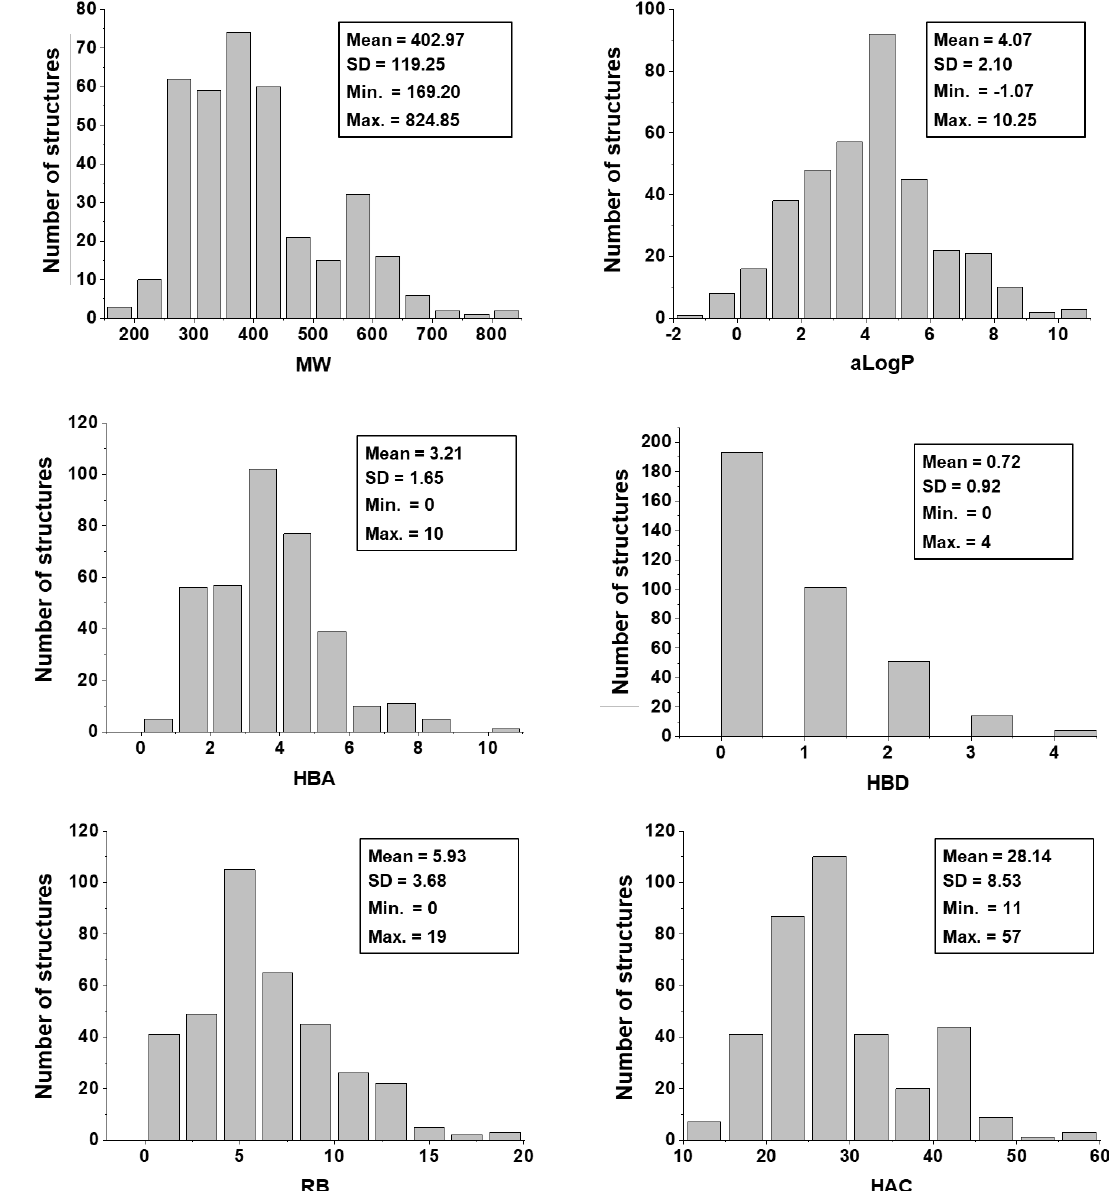
Figure 3. Distribution of physicochemical properties for the dataset. Note: MW = molecular weight; aLogP = logarithm of the octanol-water partition coefficient; HBA = hydrogen bond acceptors; HBD = hydrogen bond donors; RB = number of rotatable bonds; HAC = heavy atom count; SD = standard deviation.